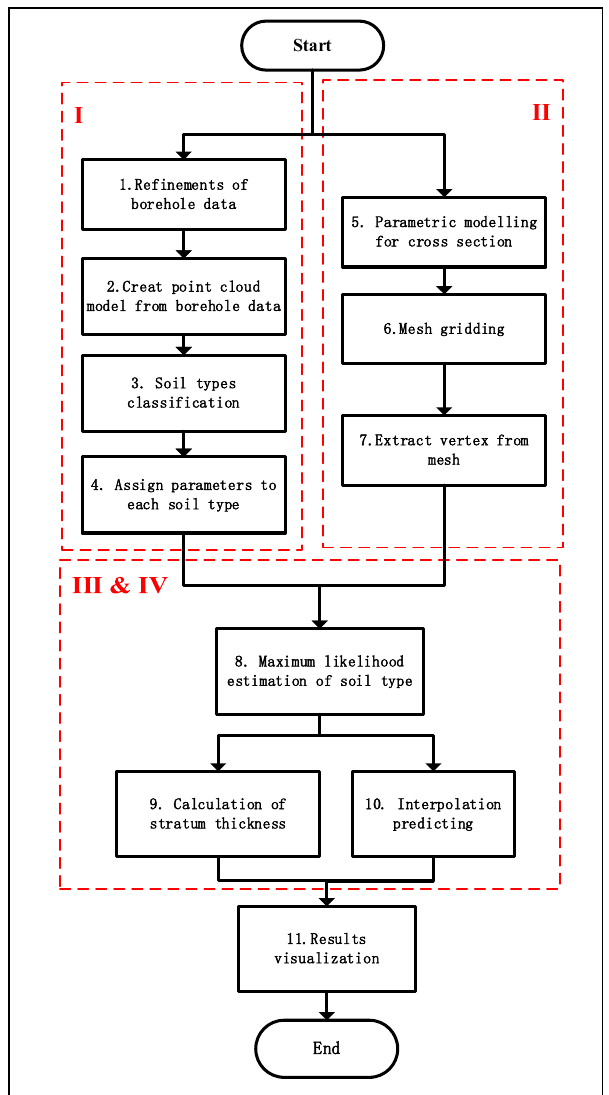
Figure 1 . Workflow of the proposed approach